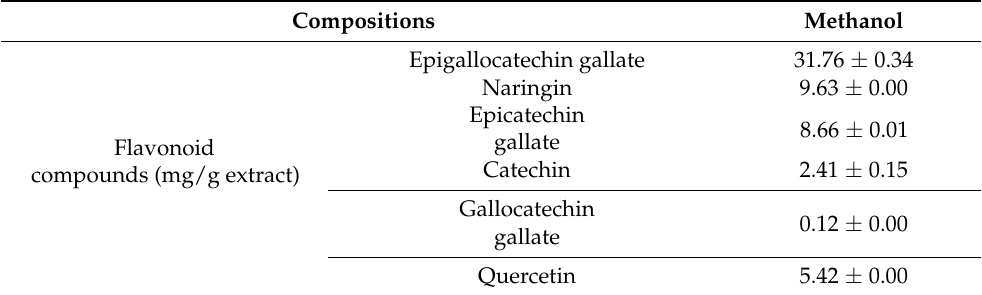
Table 2. Polyphenol compositions of the methanolic fraction of the Arabica coffee pulp